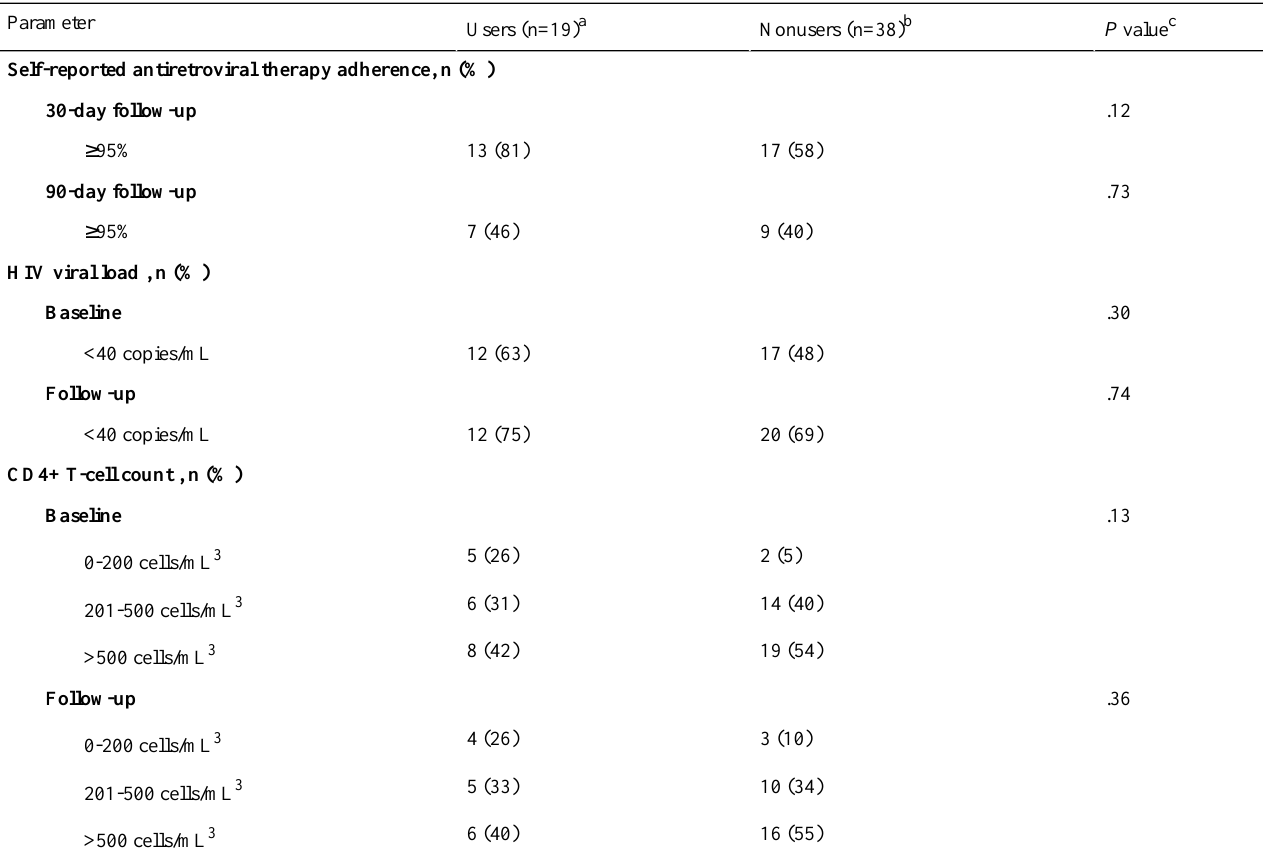
Table 2. Self-reported antiretroviral adherence and clinical parameters at 30- and 90-day follow-up among participants with <95% adherence at baseline